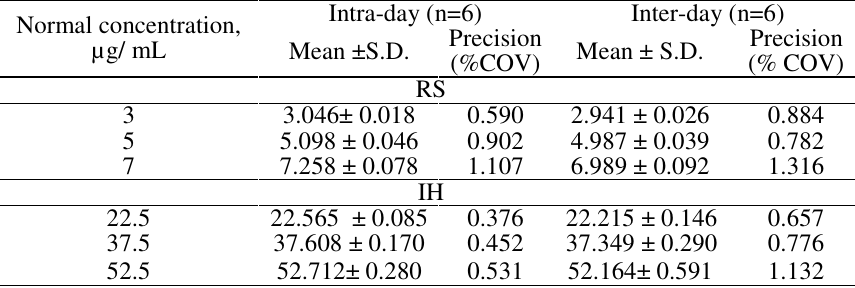
Table 4 . Intra-day and inter-day precision of HPLC